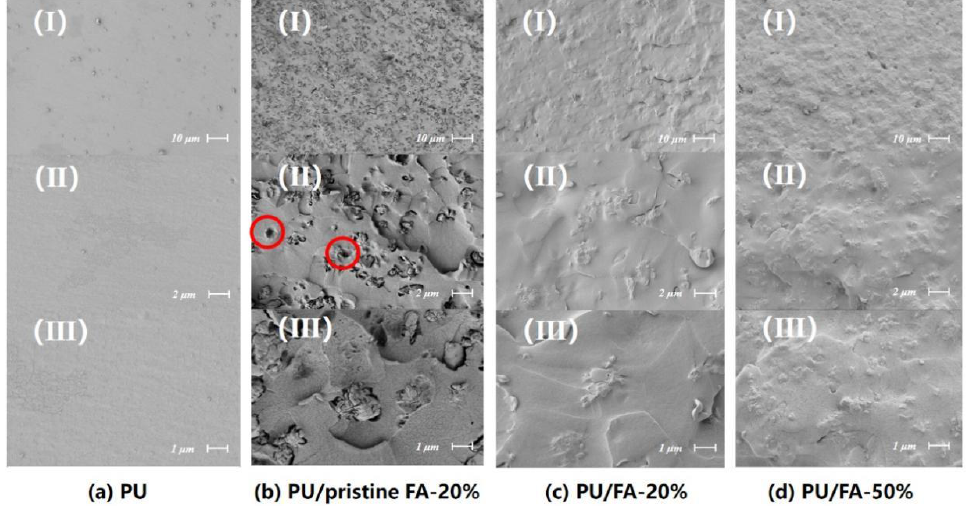
Figure 2. Fourier transform infrared spectroscopy (FT-IR) analysis of FA and modified FA ( a ); PU, PU filled with FA and PU filled with modified FA ( b ).